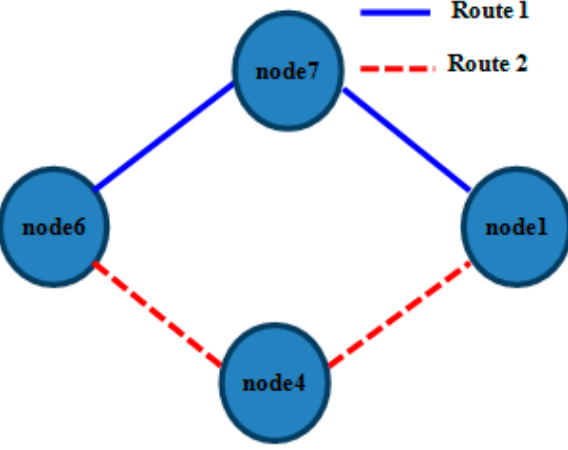
Figure 14. Deployed static topology.